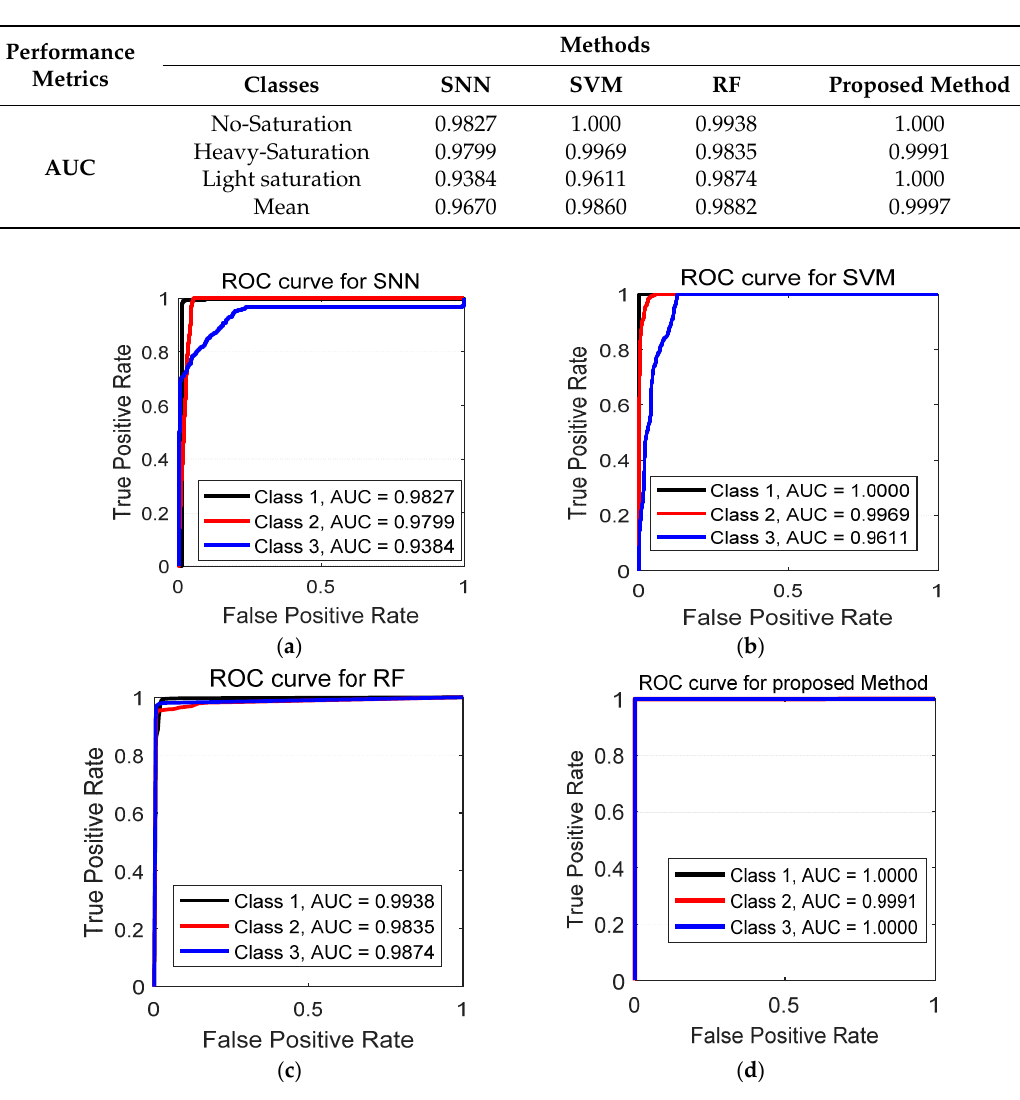
Figure 14. Displays the ROC-AUC curve of different classification models: ( a ) Performance of SNN on each class; ( b ) ROC-AUC curve on SVM experiments; ( c ) RF performance on each class; ( d ) Performance of proposed